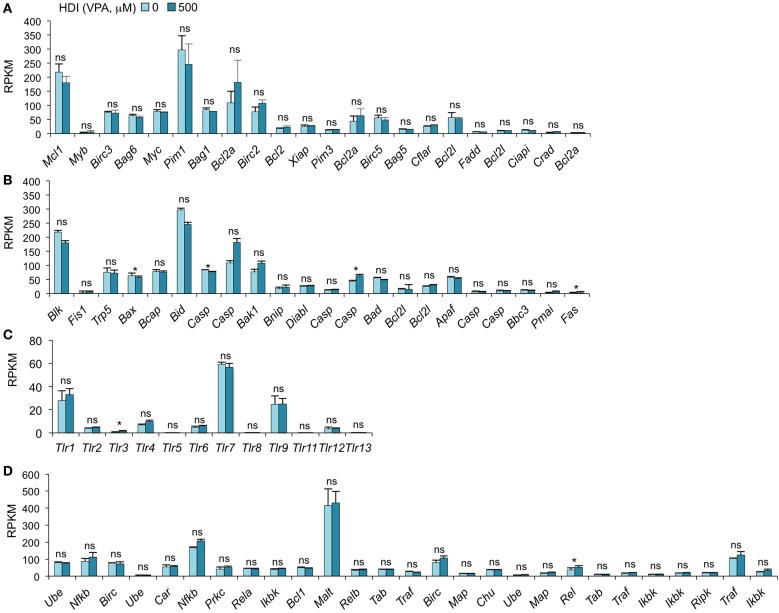
HDI does not significantly alter the expression of the genes that are important for apoptosis, the genes that encode TLRs and the genes that are involved in NF-κB signaling. B cells were stimulated with LPS plus IL-4 for 60 h, in the presence of HDI (VPA, 500 μM) or nil. mRNA expressions of the genes that encode (A) anti-apoptotic factors, (B) pro-apoptotic factors, (C) Toll-like receptors, and (D) the factors that are involved in NF-κB-signaling pathway were analyzed by mRNA-Seq and depicted as RPKM. Data are from three independent experiments. *p < 0.05; ns, not significant, paired t-test.